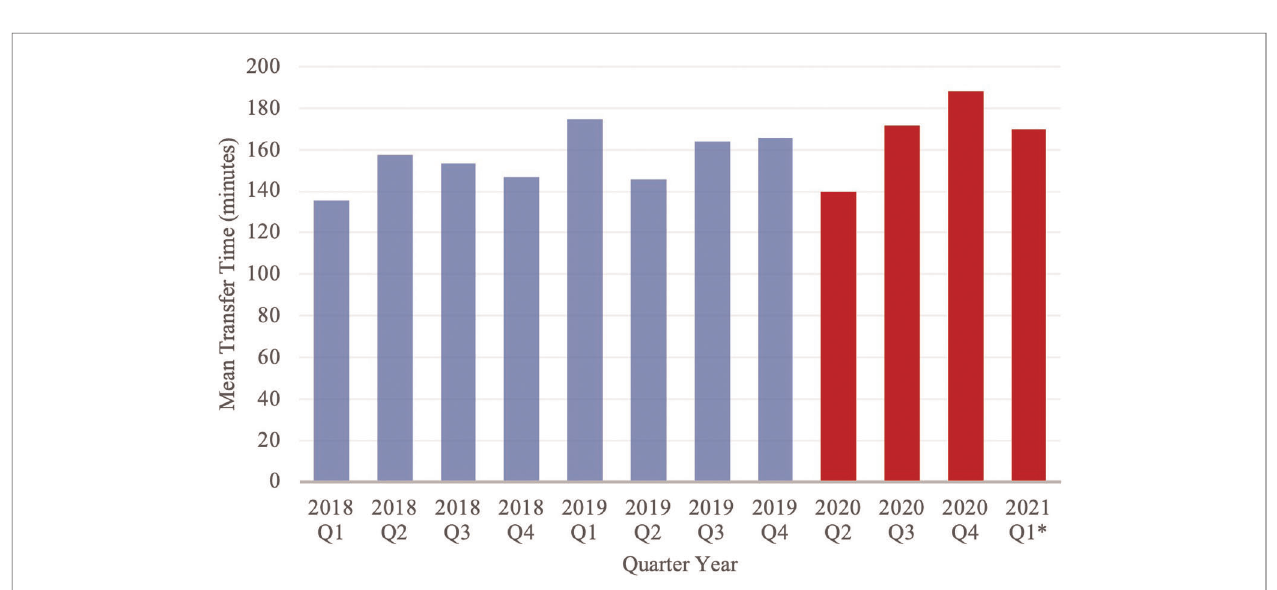
FIGURE 2 | Mean transfer time of Neuroemergent Transfers, strati fi ed by Quarter Year. Blue and red columns represent data from the PCOV and COVID cohorts, respectively. *Note: Data from 2020 Q1 has been excluded from the study; Data from 2021 Q1 only includes the months of January and